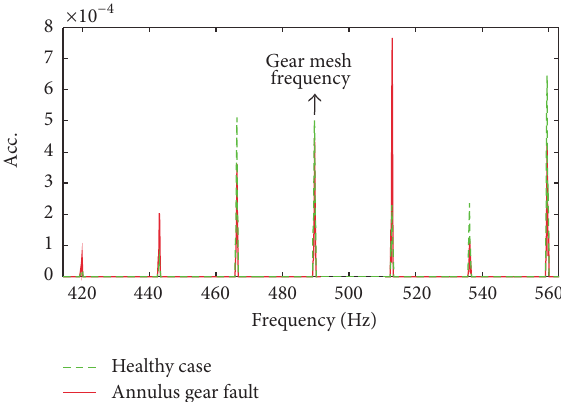
Figure 13: The processed spectrum after the diagnostic scheme around the fundamental gear mesh harmonic on the hypothesis of the annulus gear fault